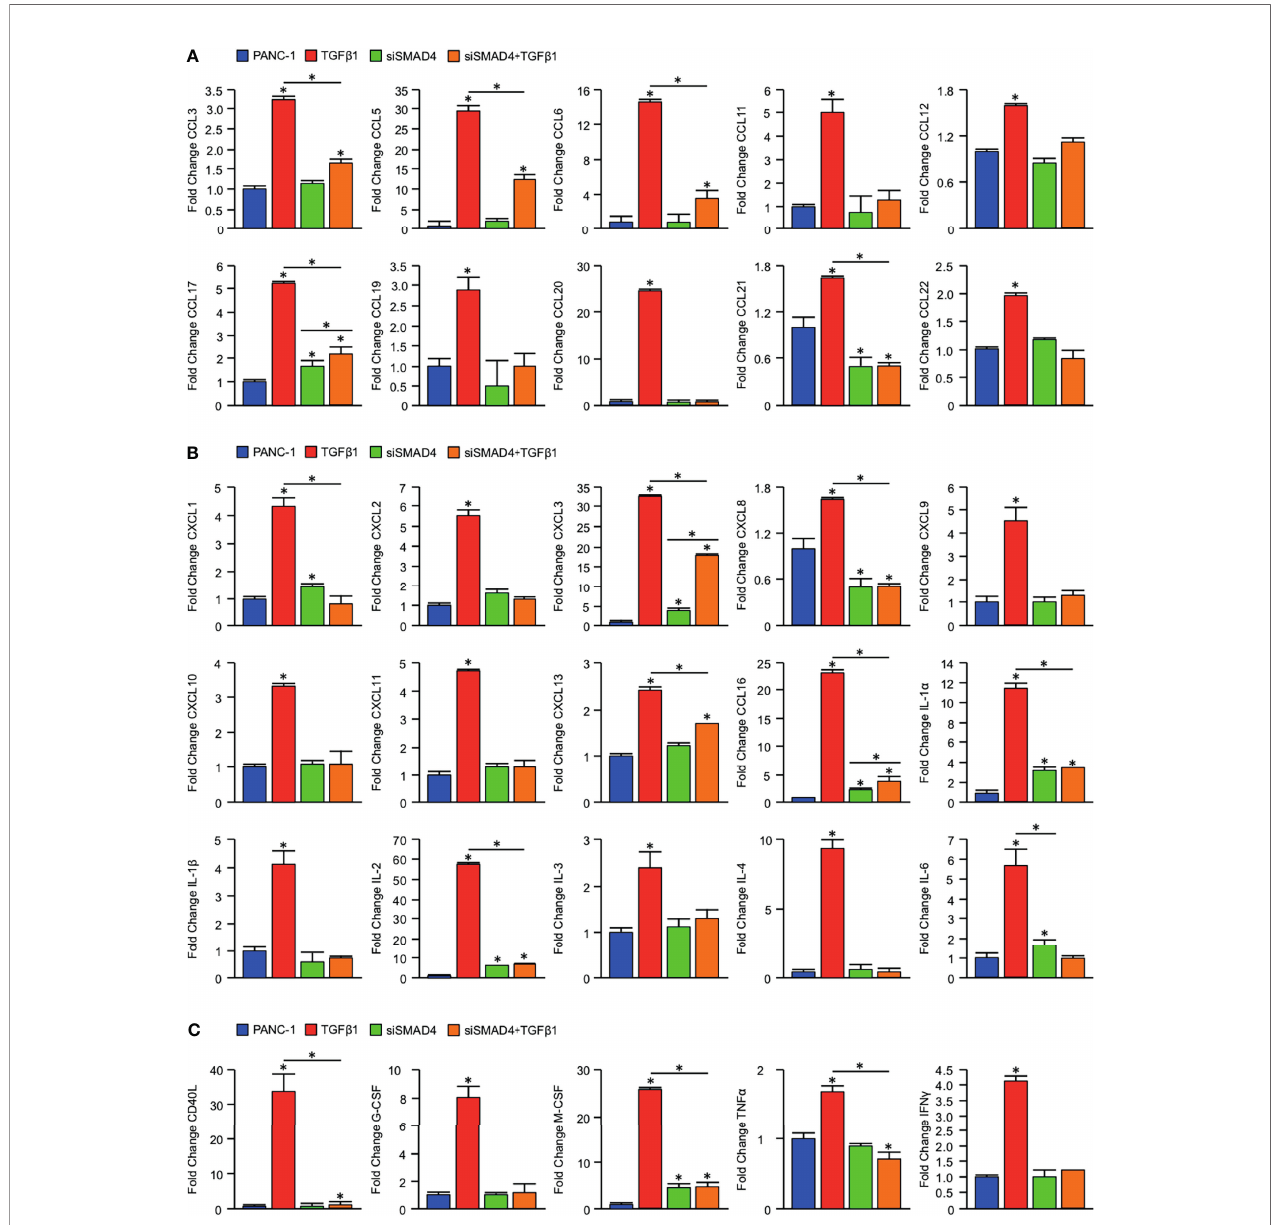
FIGURE 3 | Loss of SMAD4 impairs CCL, CXCL, and IL-family cytokine synthesis in PDAC cells. An equal number of PANC-1 cells were seeded into 6-well plates and incubated either with a control siRNA (siControl) or siRNA against SMAD4 (siSMAD4). After 24 hours, cells were treated with either a saline vehicle or 10ng/mL of recombinant TGF b 1. Following another 24 hours, cells were incubated with a protein transport inhibitor for one hour, lysed, and 200 m g of total cell lysate was evaluated by a high throughput proteome pro fi ler array (ARY022B). Pixel density was evaluated using ImageJ, and samples normalized to the mean intensity of the reference spots for each blot minus the background density. Values are presented as fold change for (A) CCL family cytokines/chemokines, (B) CXCL and IL family cytokines/chemokines, (C) additional immunomodulatory proteins. (*p <